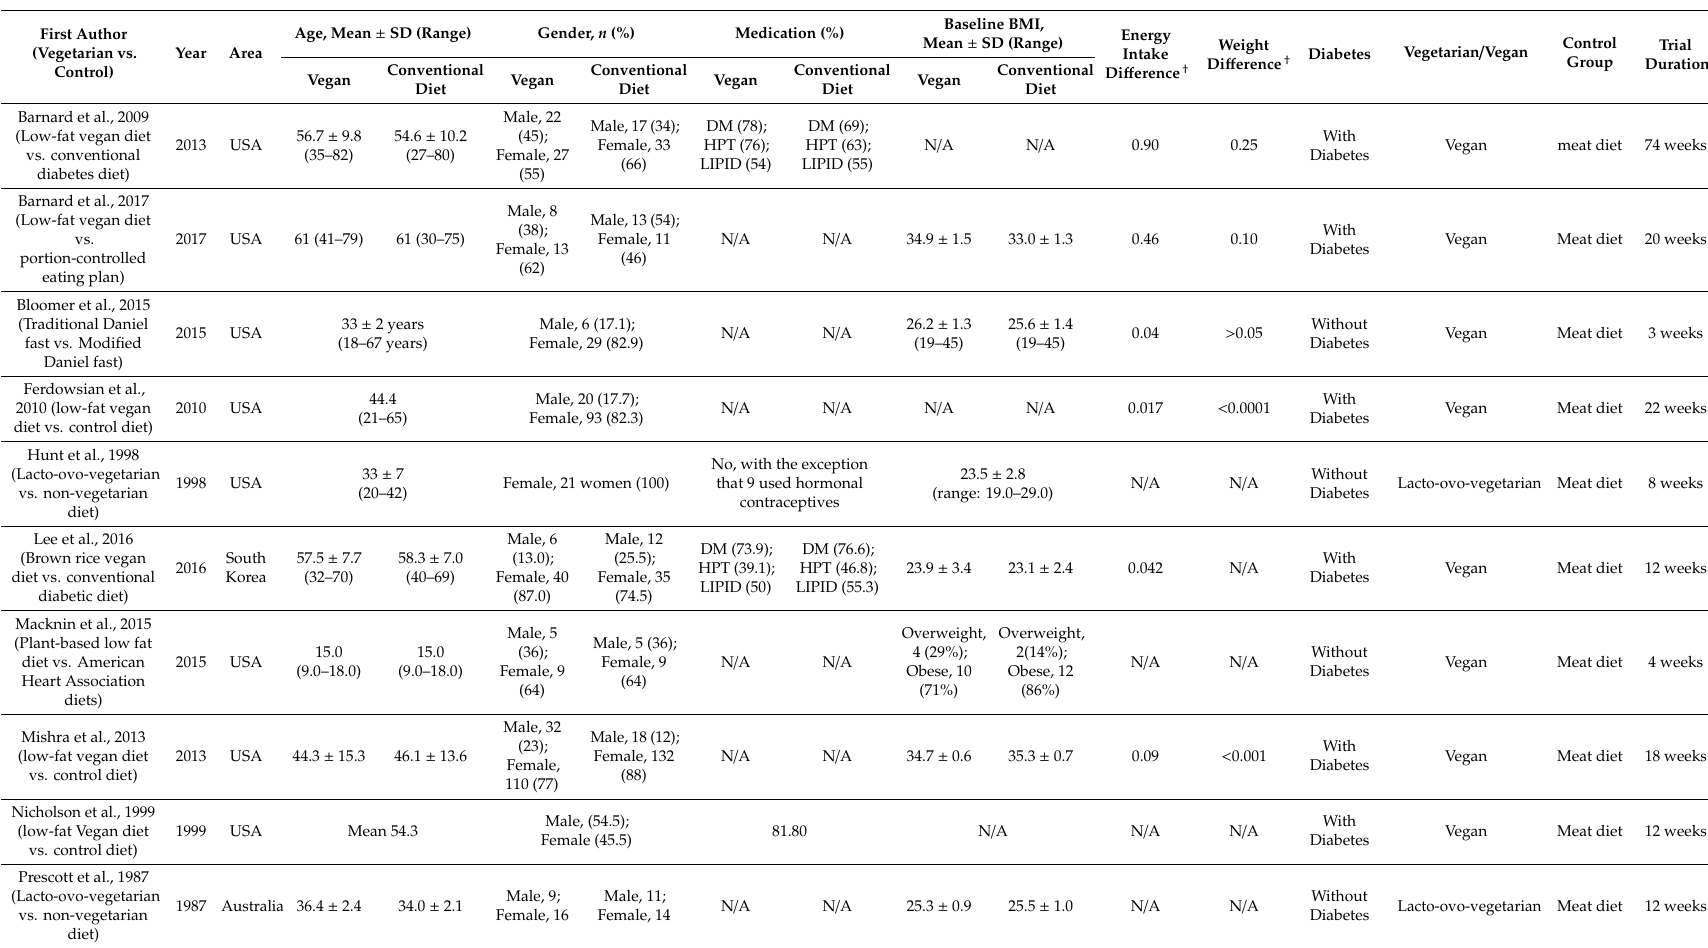
Table 1. Characteristics of